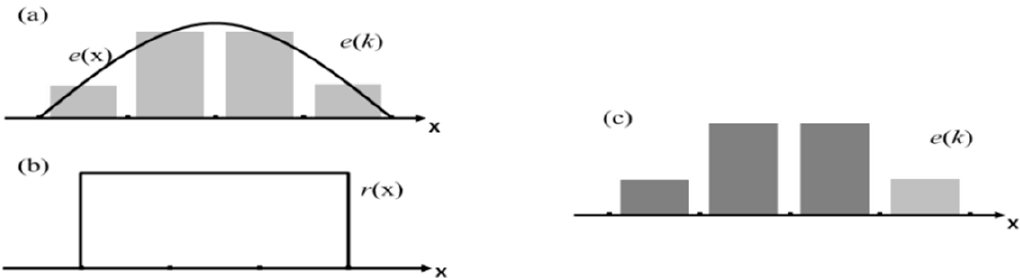
Figure 3. A truncated pixel detected signal in the centroid estimation process. ( a ) Signal intensity profiles and pixel detected signal (line: signal intensity profile e ( x ), bar: pixel detected signal e ( k )). ( b ) The three-pixel sampling window r ( x ). ( c ) The windowed pixel signal (dark bar: pixel detected signal in r ( x ), light bar: pixel detected signal outside r ( x )).